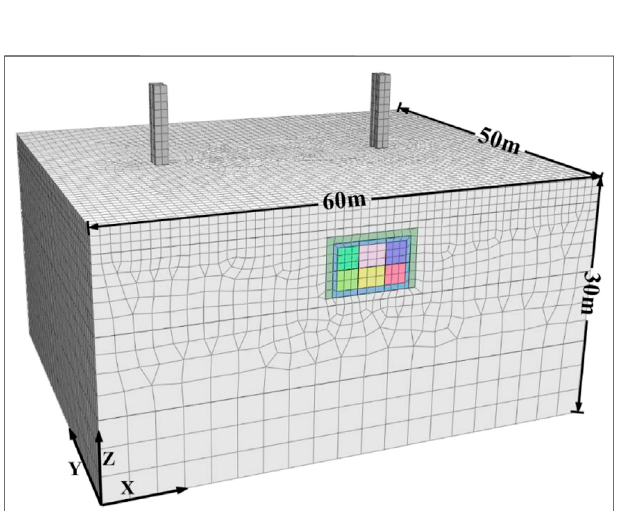
FIGURE 2 | Excavation and temporary lining dismantling method: (A) Excavation method; (B) Temporary lining dismantling method.